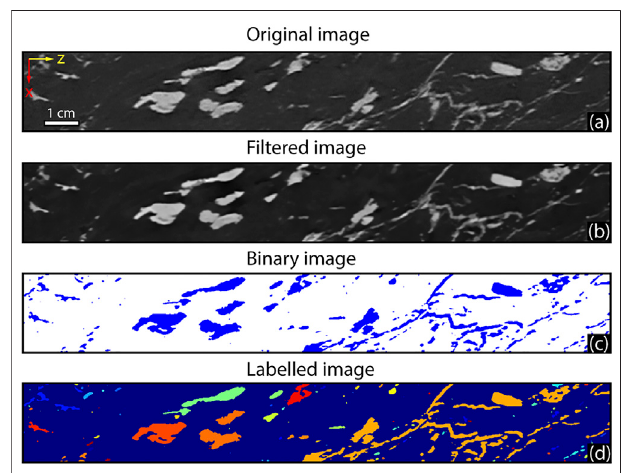
FIGURE1| 2D sliceof3DComputedTomography (CT) image ofafelsic lava scanned at 140 keV with a medical CT scanner and a voxel size of 0.4 mm 3 (A) .Theimagewas fi ltered withamean fi lter (B) and theoxideswere segmented (C) and labeled (D)